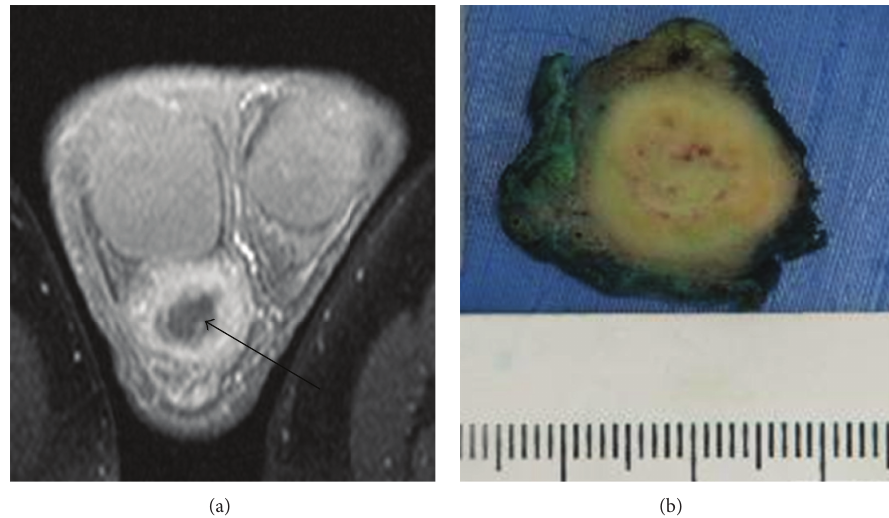
Figure 1: (a) Cross-sectional MRI shows peripheral enhancement of the lesion, which is clearly separate from the testis and demonstrates a central area of necrosis. (b) Cut surface of the specimen shows a yellow tumour mass with central necrosis.